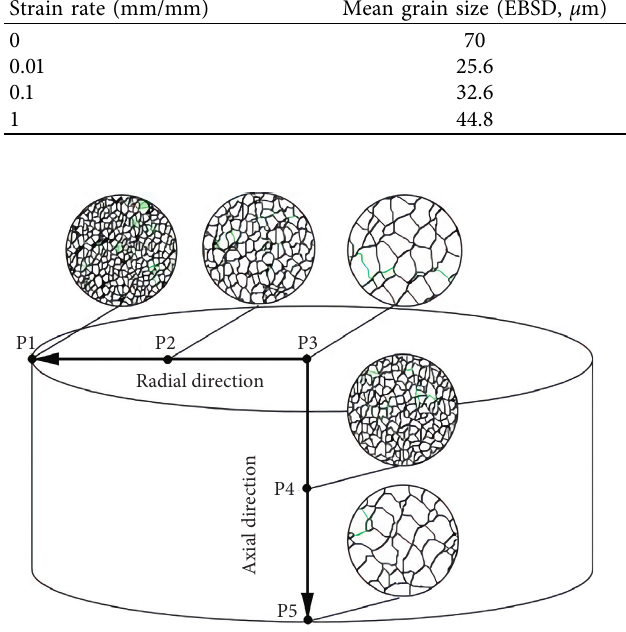
Figure 3: The grain size distribution of the cylinder sample with strain rate of 0.01s − 1 at 350 °